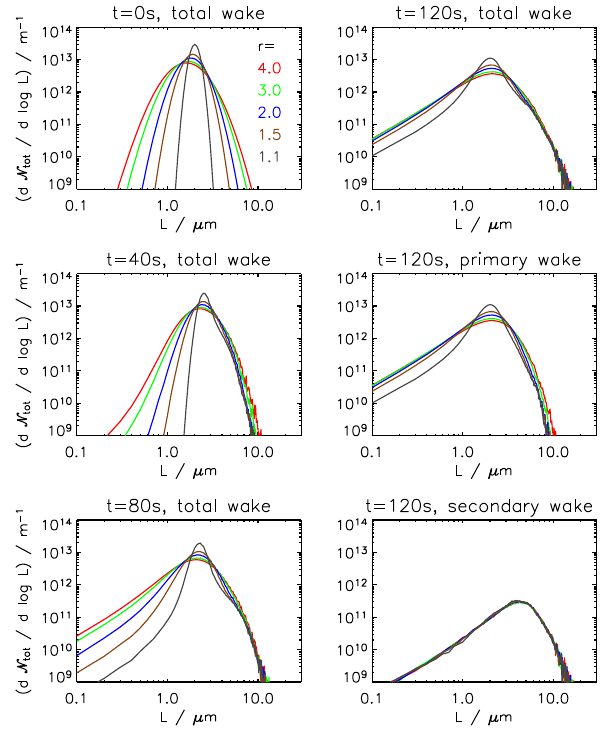
Fig. 6. Size distributions for various widths r of the initial size distribution (see legend) for the LCM-model at T ∗ =217 K and RH ∗ i =120% . The time of evaluation and the sampling area is given on top of each plot.